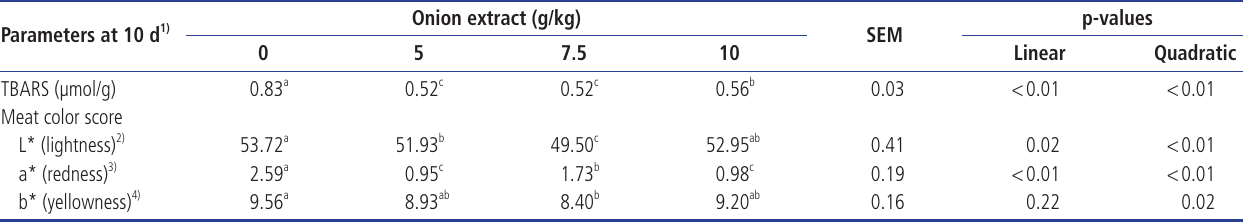
Table 7. Effect of dietary onion extract supplementation on TBARS value and color score of broiler meat Parameters at 10 d